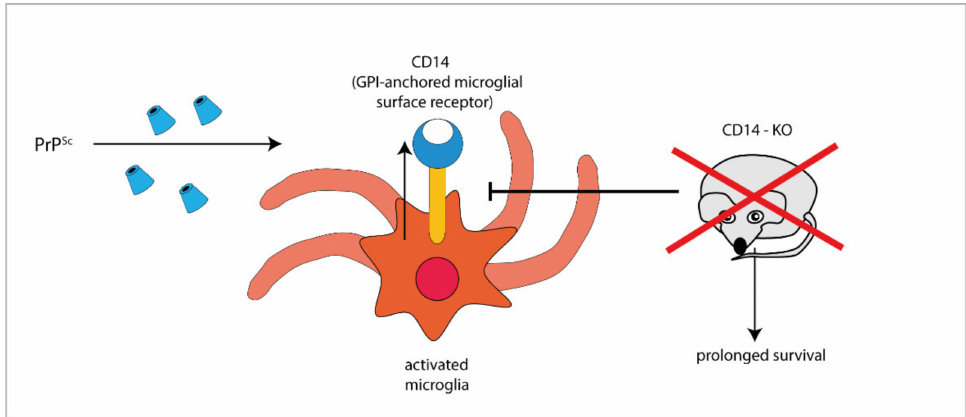
Figure 1. The GPI-anchored cell surface TLR co-receptor CD14 is upregulated in microglial cells during prion infection, while CD14 genetic deletion blocks (T-arrow) CD14 upregulation and prolongs survival in prion infected knock-out mice (red ×